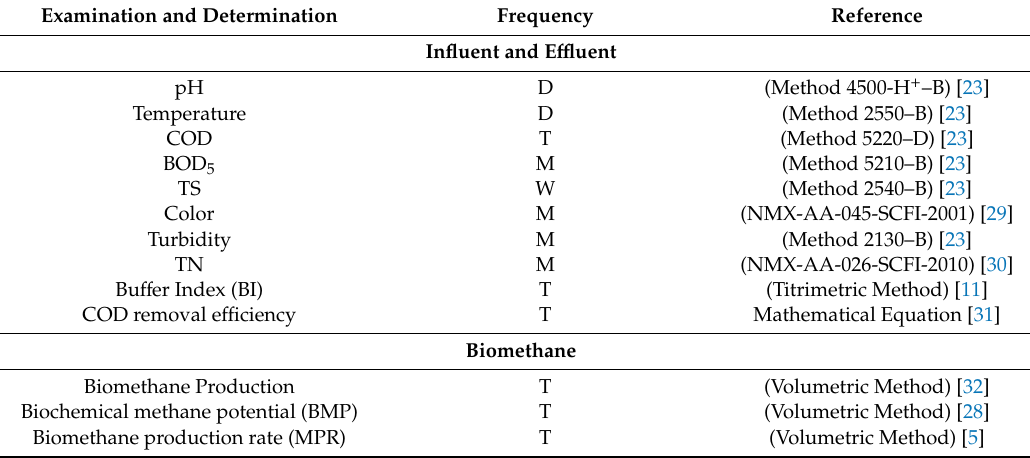
Table 1. Determination and examination, frequency and bibliographic reference of the methodologies used for influent, effluent, and biomethane.